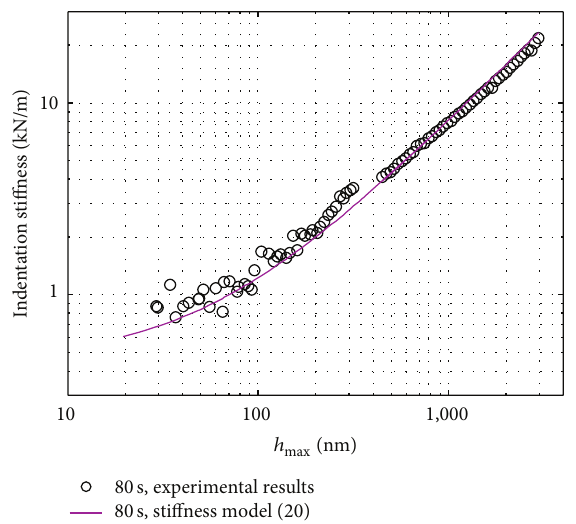
Figure 31: Comparison of the experimental stiffness 𝐾 m of epoxy obtained with a Berkovich tip with the indentation stiffness model (20) where 80s loading time was used in nanoindentation experi- ments